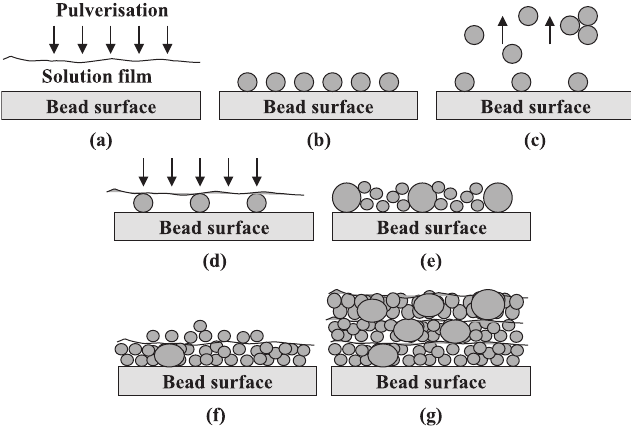
Fig. 7 Formation of a solid film and particles on the beads’